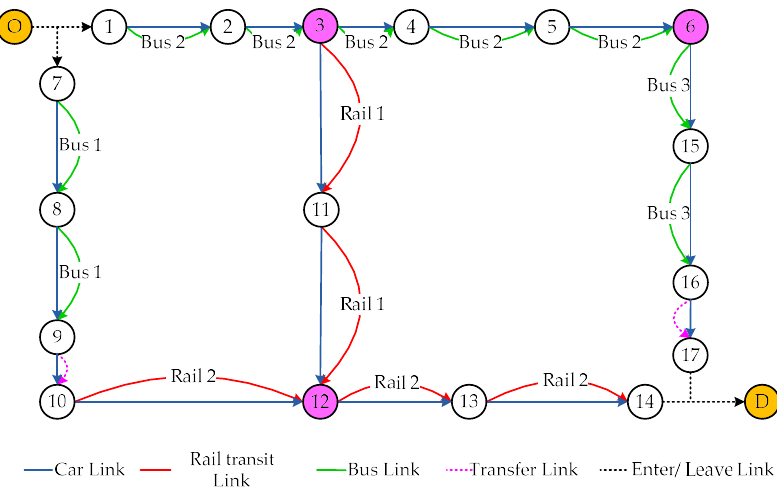
Figure 2. The diagram of the multimodal transportation network.